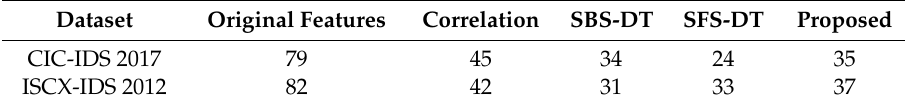
Table 5. Original number of features and features selected by each feature selection method.